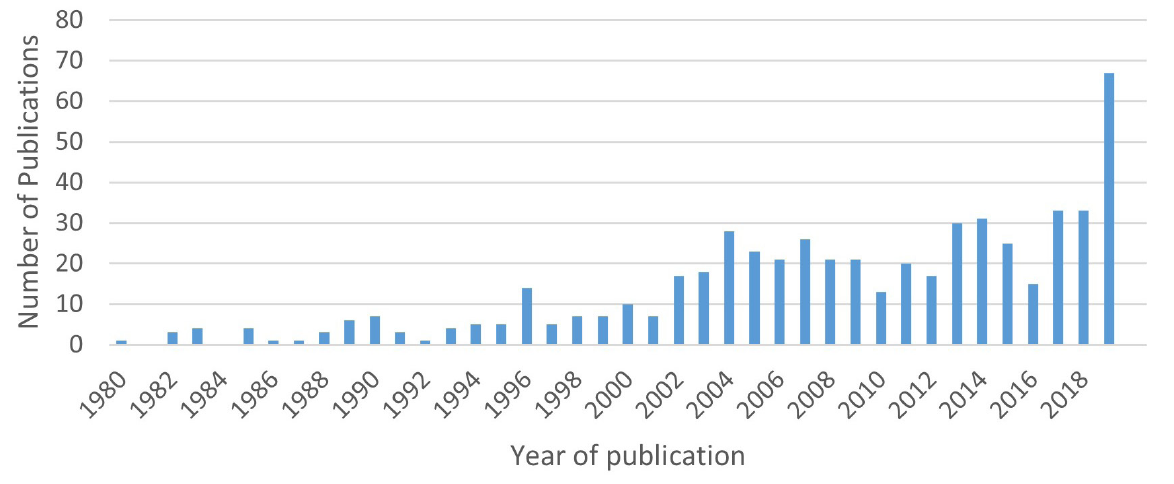
Figure 2. Evolution of the number of publications per